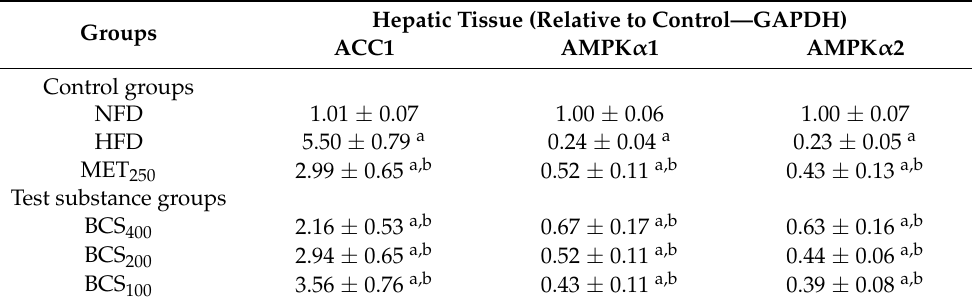
Table 10. The mRNA expressions of genes involved in liver lipid metabolism in the HFD- and NFD-supplied